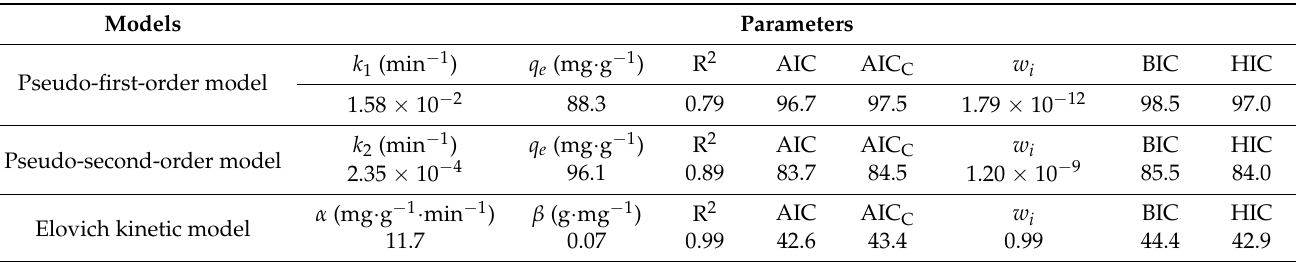
Table 1. Results of adsorption kinetics